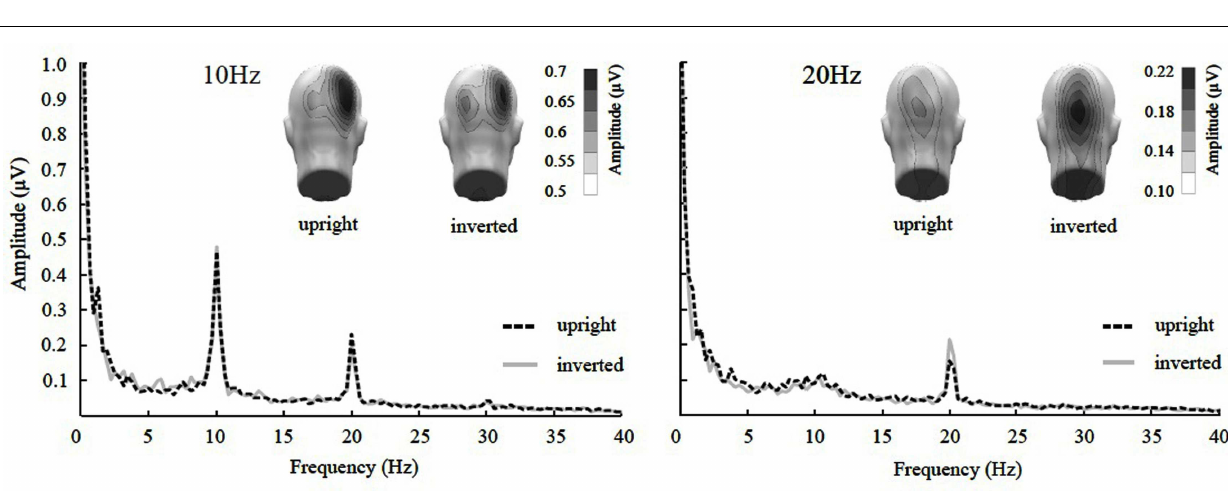
three-way interaction indicated that with inversion, N170